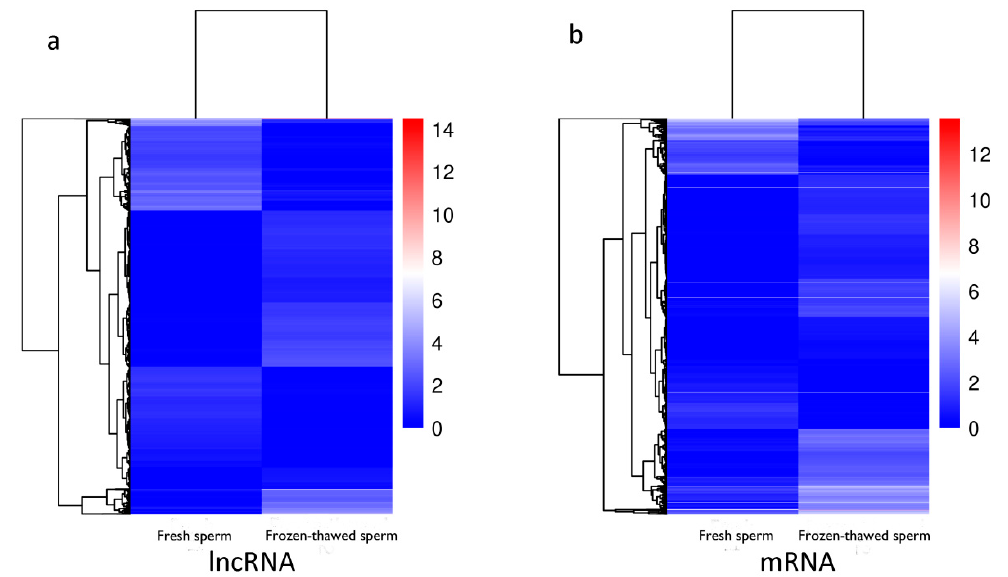
Figure 4. The heat maps of Cluster analysis of differentially expressed lncRNAs and mRNAs. ( a ) lncRNAs, ( b ) mRNAs. Red color indicated an increase in expression, and blue color indicated a decrease in expression.